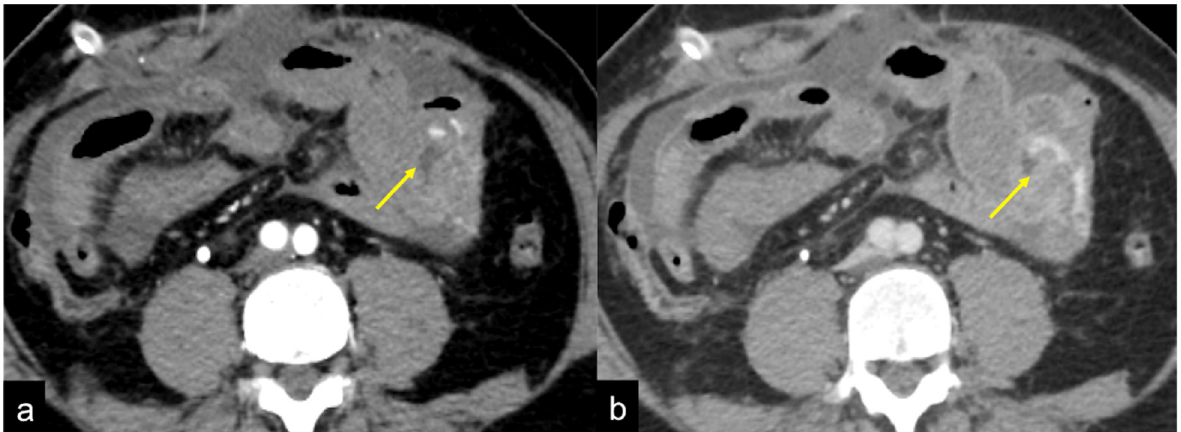
Figure 10. CT multiphasic study of active bleeding in the jejunum. In the arterial phase ( a ), a blush of active bleeding is detected (arrow). In the venous phase ( b ), the increase in haemorrhagic blush is documented with contiguous small bowel loop involvement.